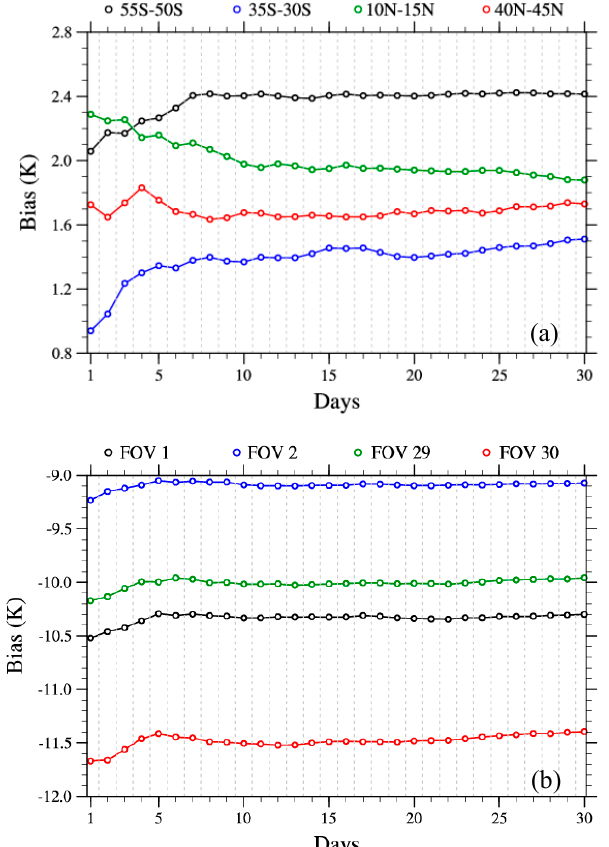
Figure 4. “Variations in clear-sky O-B biases over oceans for AMSU-A channel 3 with respect to the number of days from 1 July to 30 July 2014: ( a ) The O-B biases using nadir data within latitudinal bands of 55 ◦ S-50 ◦ S (black), 35 ◦ S~30 ◦ S (blue), 10 ◦ N~15 ◦ N (green), and 40 ◦ N~45 ◦ N (red), as well as ( b ) the O-B biases for data at FOVs 1 (black), 2 (blue), 29 (green), and 30 (red). Clear-sky data points are defined by LWP < 0.05 kg m − 2 .